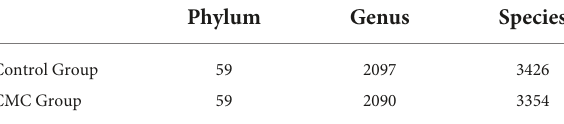
TABLE 2 Bacterial composition in each group at different levels.